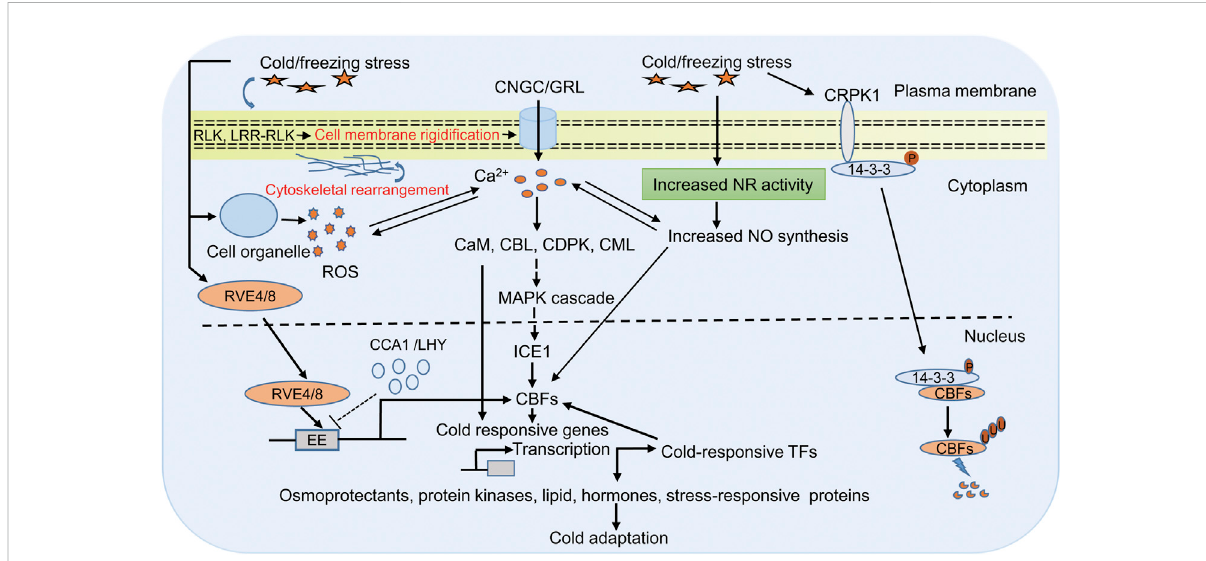
FIGURE 1 Representativediagramofcoldresponsivesignalingpathwayinplants.Plantssensecold/freezingsignalsthroughmembranereceptor(RLKand LRR-RLK) and membrane rigidi fi cation. Cold sensing activates calcium channels (CNGC/GRL) that lead to increase Ca 2+ in cytoplasm, which in turn activatesofCa 2+ relatedproteinlikases(CaM,CML,CDPKs, andCBLs)anddownstreamsignaling includingMAPKsignaling.Thesesignalingcascades fi nally interacts with ICE1 and controls expression of CBFs/COR genes. COR genes encode proteins required for the biosynthesis of osmoprotectants, cryoprotectants, protein kinases, lipid, hormone, and stress-responsive proteins that are directly involved in cold tolerance. In addition, COR gene-dependent responses involve expression of diverse cold-induced transcription factors, which regulates CBFs expression in either positive or negative manner. The cold/freezing stress and increased Ca 2+ activates the NADPH to generate more ROS. ROS and Ca 2+ regulate eachother ’ sconcentration,andthiscrosstalkcontrolstheexpressionofdefensegeneinthenucleus.Cold/freezingstressalsotriggersNOsynthesis that is essential for cold acclimation response through CBF dependent manner. In another cold signaling pathway, 14-3-3 protein get phosphorylation by CRPK1 followed by translocation from the cytoplasm to the nucleus where it interacts with CBFs and trigger its degradation through the 26S proteasome pathway. In Arabidopsis, clock related MYB proteins RVE4/RVE8 plays an direct transcriptional activators of DREB1 expression in cold stress. In unstressed condition CCA1 and LHY suppressed DREB1 expression, wheras in stressed condition RVE4/ RVE8 translocate from cytoplasm to the nucleus and induces the expression of CBFs/DREB1 through cis acting element EE by rapidly degrading CCA1and LHY. Abbreviations: RLK, receptors like protein kinases; LRR-RLK leucine-rich repeats receptor-like protein kinase; CNGC, cyclic nucleotide-gated calcium channel; GLRs, glutamate-like receptor homologs; Ca 2+ , calcium ion; calcium binding proteins like CaM, calmodulin; CML, CaM-like proteins; CDPKs, Ca 2+ dependent protein kinases; CBLs, calcineurin B-like proteins; MAPK, mitogen-activated protein kinase; CBFs, C-repeat Binding Factors; ICE, Inducer of CBF Expression; COR, cold-responsive; ROS, reactive oxygen species; NO, nitric oxide; CRPK1, cold- responsive protein kinase 1; RVE4/8, reveille4/8; lhy-cca1-Like1 (/LCL1); CCA1, circadian clock ’ s oscillator component circadian clock-associated1; LHY, late elongated hypocotyl; EE, cis acting element; TFs, transcription factors; DREB1, dehydration responsive element binding-protein